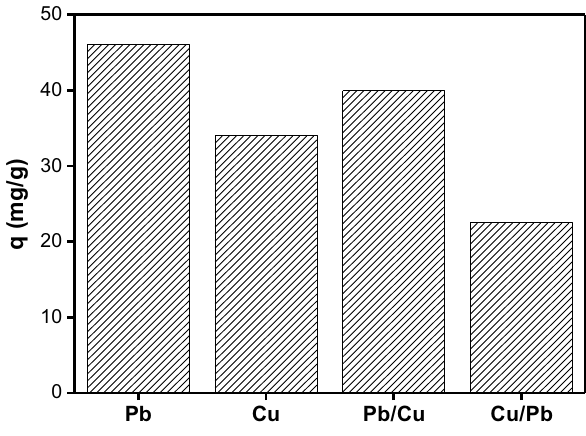
0 Fig. 11 Effect of regeneration of DES/H